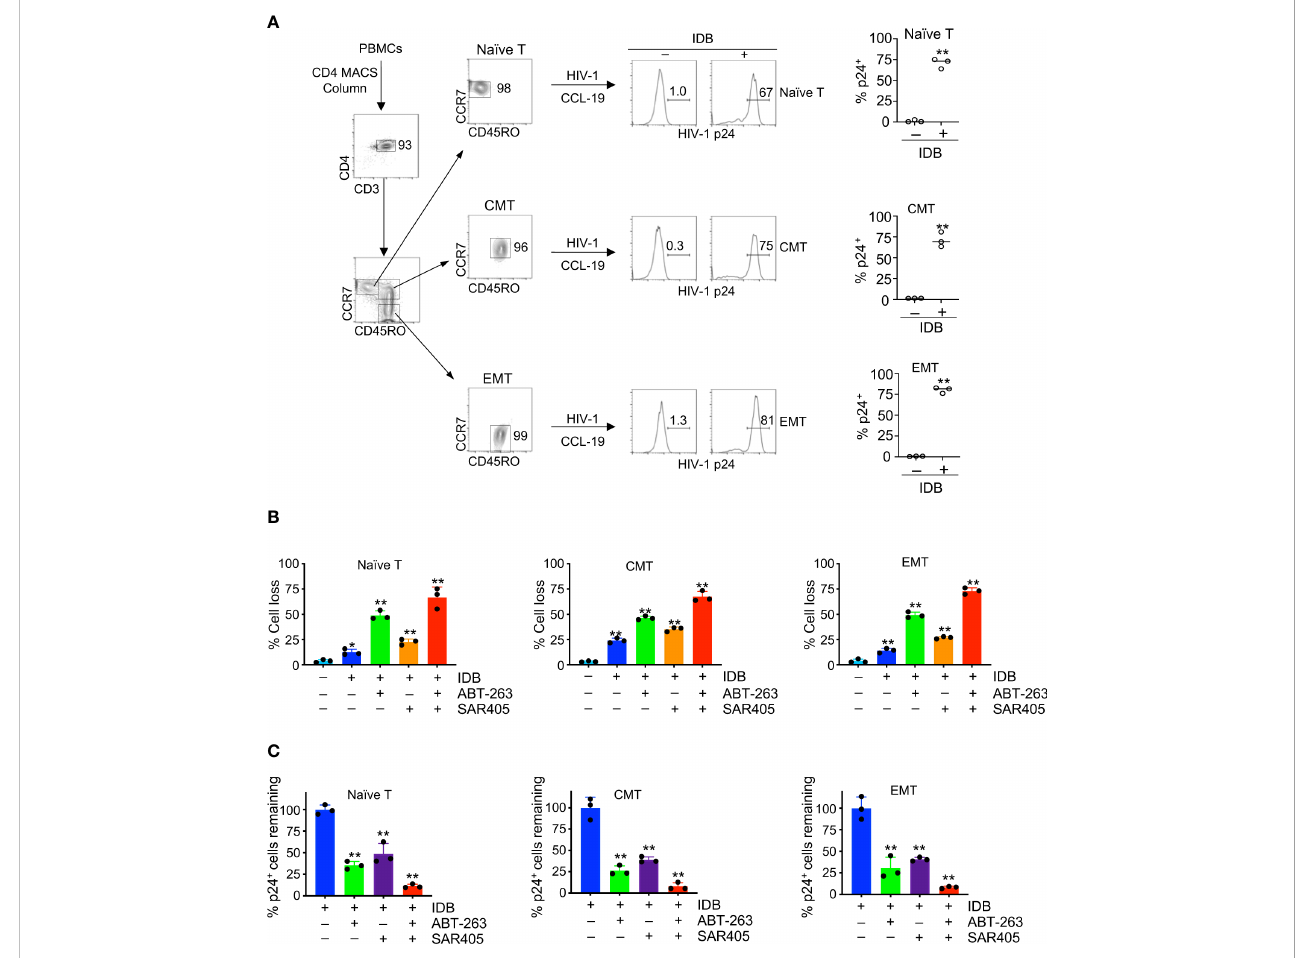
FIGURE 4 Induction of cell death in HIV-1-infected naïve, central memory and effector memory T cells. (A) CD4 + T cells were puri fi ed from human PBMCs using anti-CD4-MACS beads (Miltenyi Biotec), and naïve, central memory (CMT) and effector memory T cells (EMT) were sorted by fl ow cytometry. Sorted T cell subsets were infected with HIV-1 (NL4-3, 1 MOI). Latent infection was then established by culturing with CCL-19 for 4 days, followed by stimulation with IDB for 24 h. Intracellular staining of HIV-1 p24 was determined by fl ow cytometry. (B, C) The cells with or with latent HIV-1 infection as in (A) were treated for 48 h with IDB (0.1 m M), ABT-263 (0.2 m M) and SAR405 (2 m M) as indicated. The cells were then stained with DEVD-FITC and APC-Annexin V, followed by intracellular staining with PE-anti-HIV p24. Total cell death for cells (B) and the remaining viable HIV-1 p24 + cells negative for staining